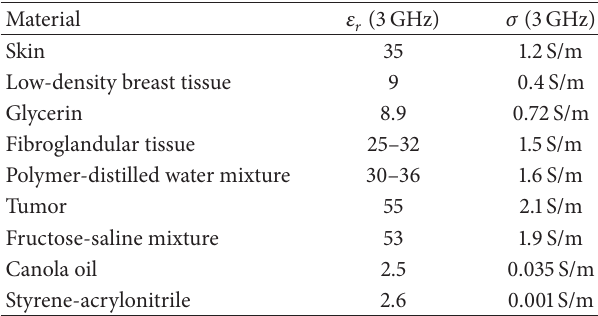
Table 3: Dielectric properties of breast tissues and the materials used in the experimental